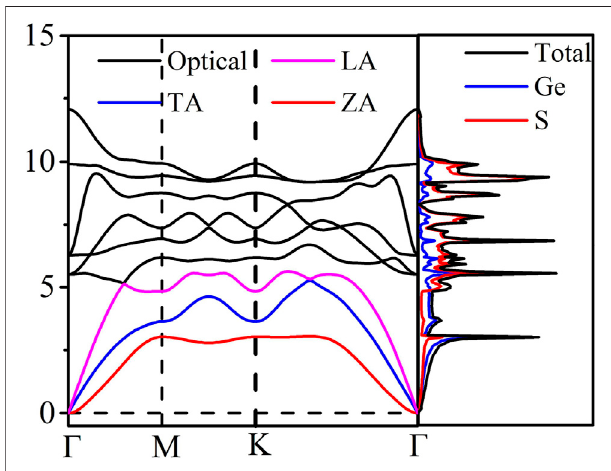
FIGURE 3 | Phonon dispersion and phonon DOS for monolayer GeS 2 .